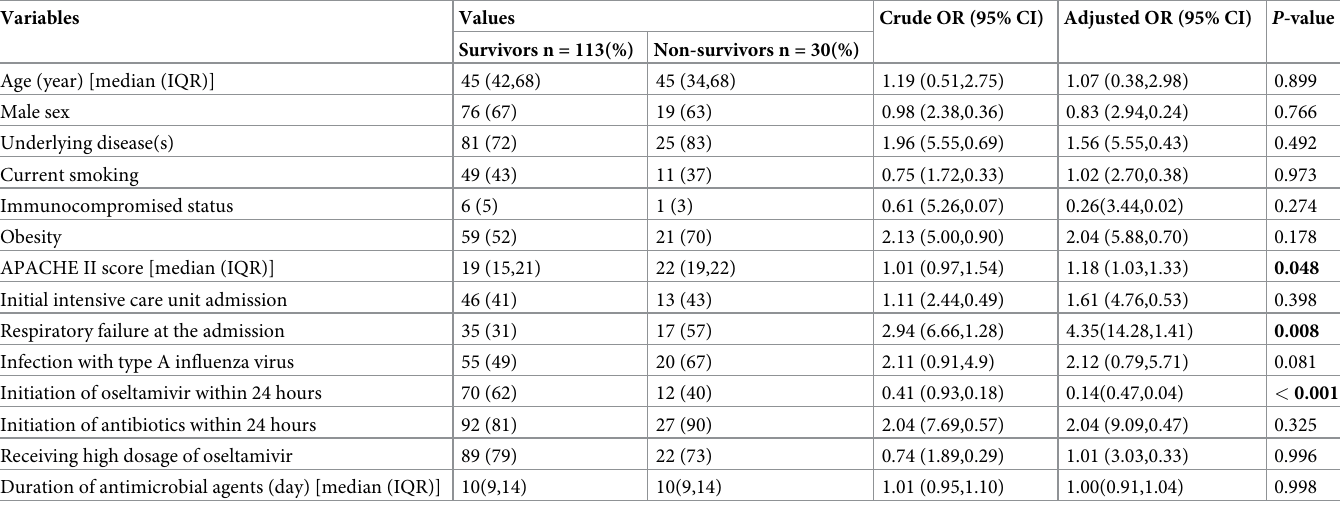
Table 3. Factors influencing 30-day mortality among 143 patients with community-acquired influenza pneumonia.